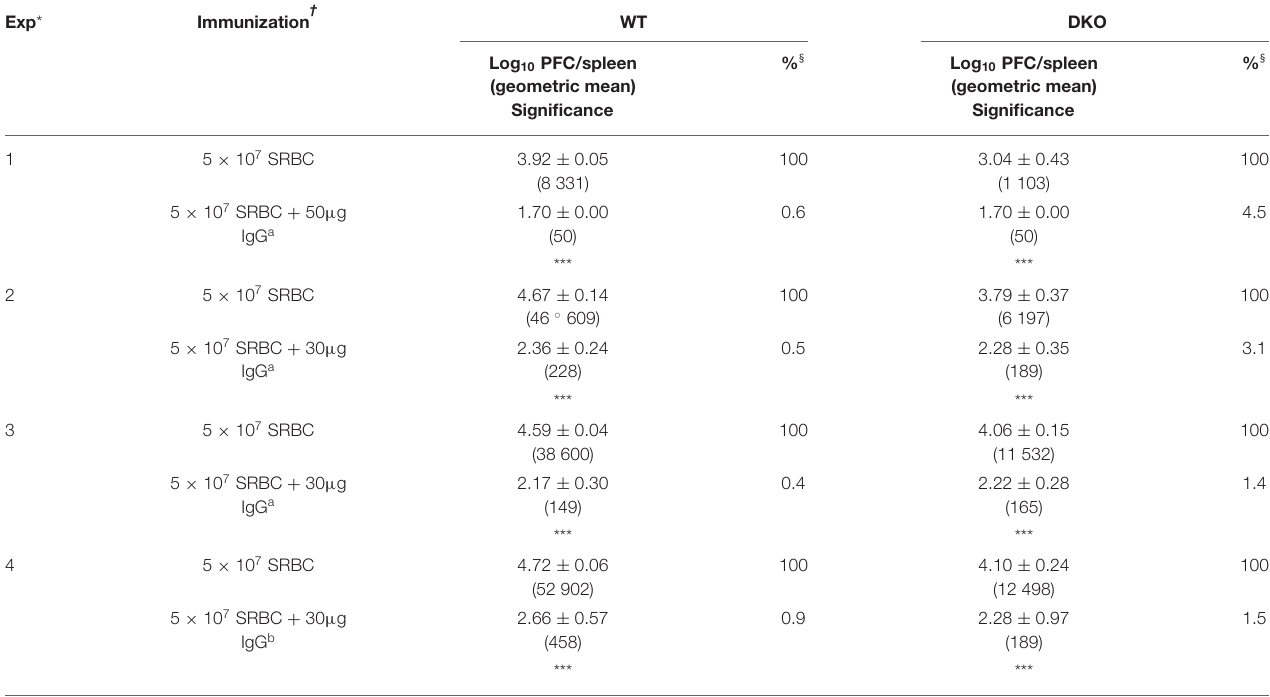
TABLE 1 | IgG suppresses IgM anti-SRBC responses both in WT and (C3 × Fc γ R) DKO mice. † Exp * Immunization